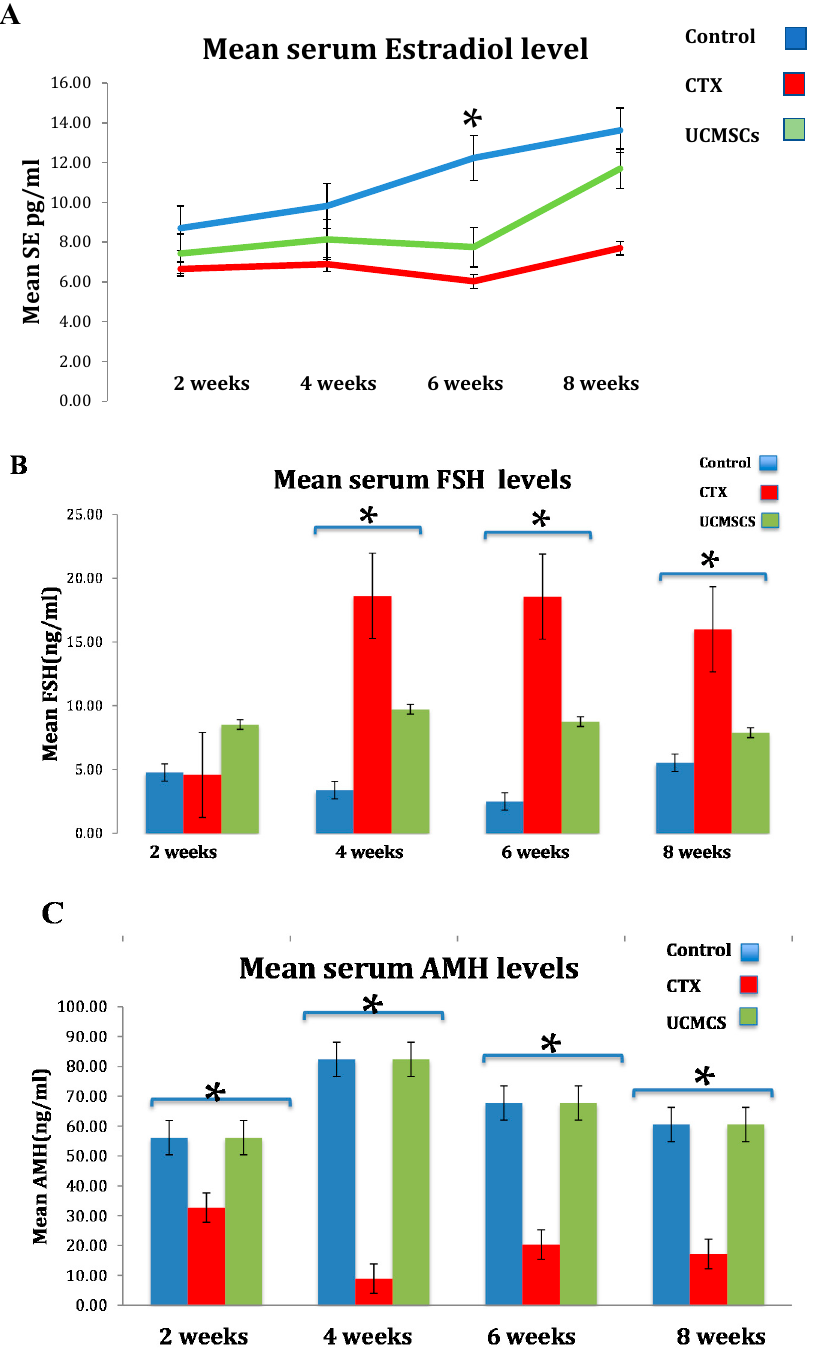
Figure 4. UCMSCs significantly recover ovarian hormonal profile as illustrated by the bar graph in ( A ) Estradiol levels explained the rise in favor of UCMSCs; ( B ) Low follicle stimulating hormone (FSH) levels were significantly represented in UCMSCS from 4 weeks and over; ( C ) anti-Mullerian hormone (AMH) levels were significantly increased in UCMSCS groups in all time points (* p < 0.05)